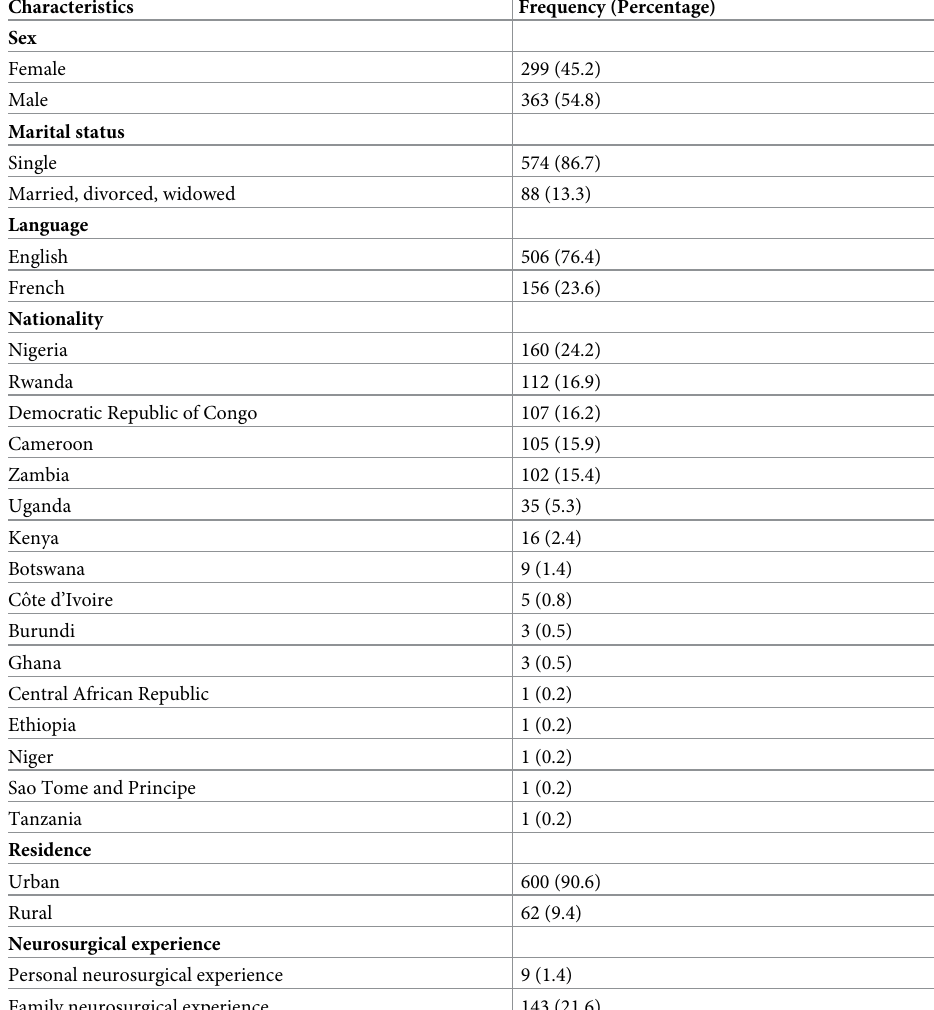
Table 1. Sociodemographic characteristics of survey